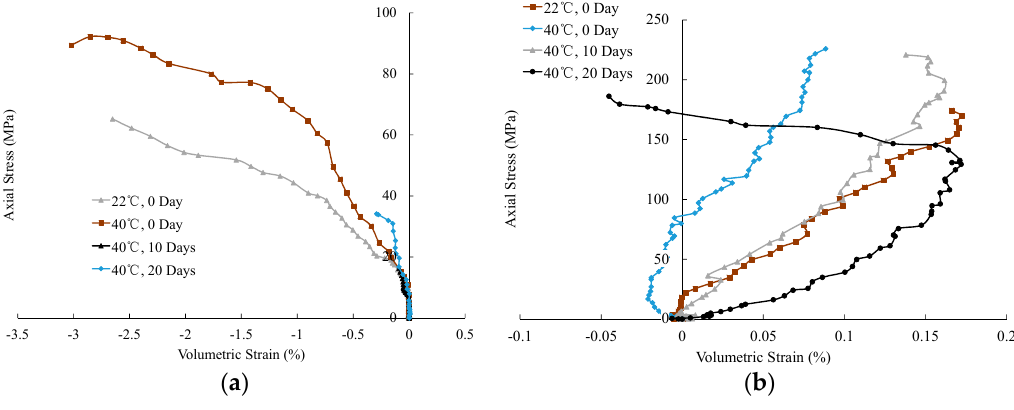
Figure 4. Axial stress ‐ volumetric strain curves: ( a ) parallel; ( b ) normal.